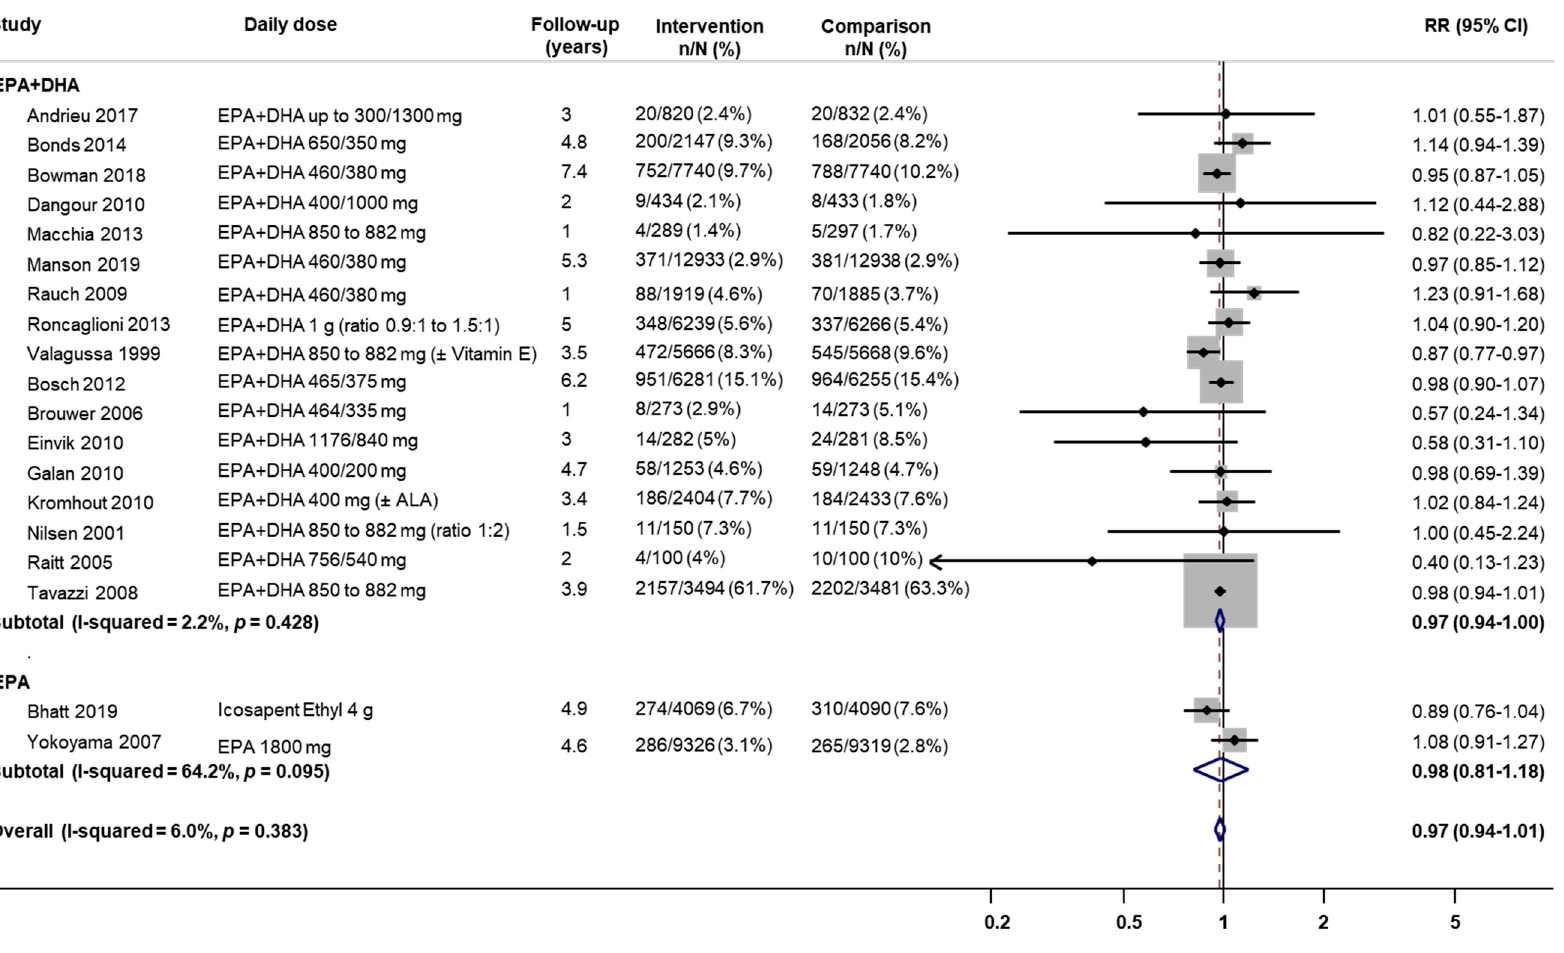
Figure A6. Subgroup meta-analysis for the effect of different omega-3 supplementation types on all-cause mortality. Full black quadrilateral represents the point estimate of individual studies and blank with quadrilateral represents pooled estimates. RR, relative risk; CI, confidence interval; EPA, eicosapentaenoic acid; DHA, docosahexaenoic acid. ALA, alpha-linolenic acid. Pooled estimates for the overall study population and subgroups are highlighted with bold